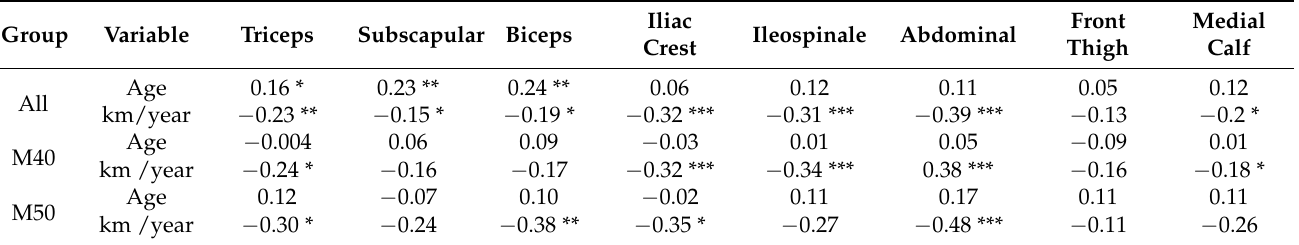
Table 2. Spearman’s rank correlation coefficients between eight skinfolds and age and km/year in all groups.